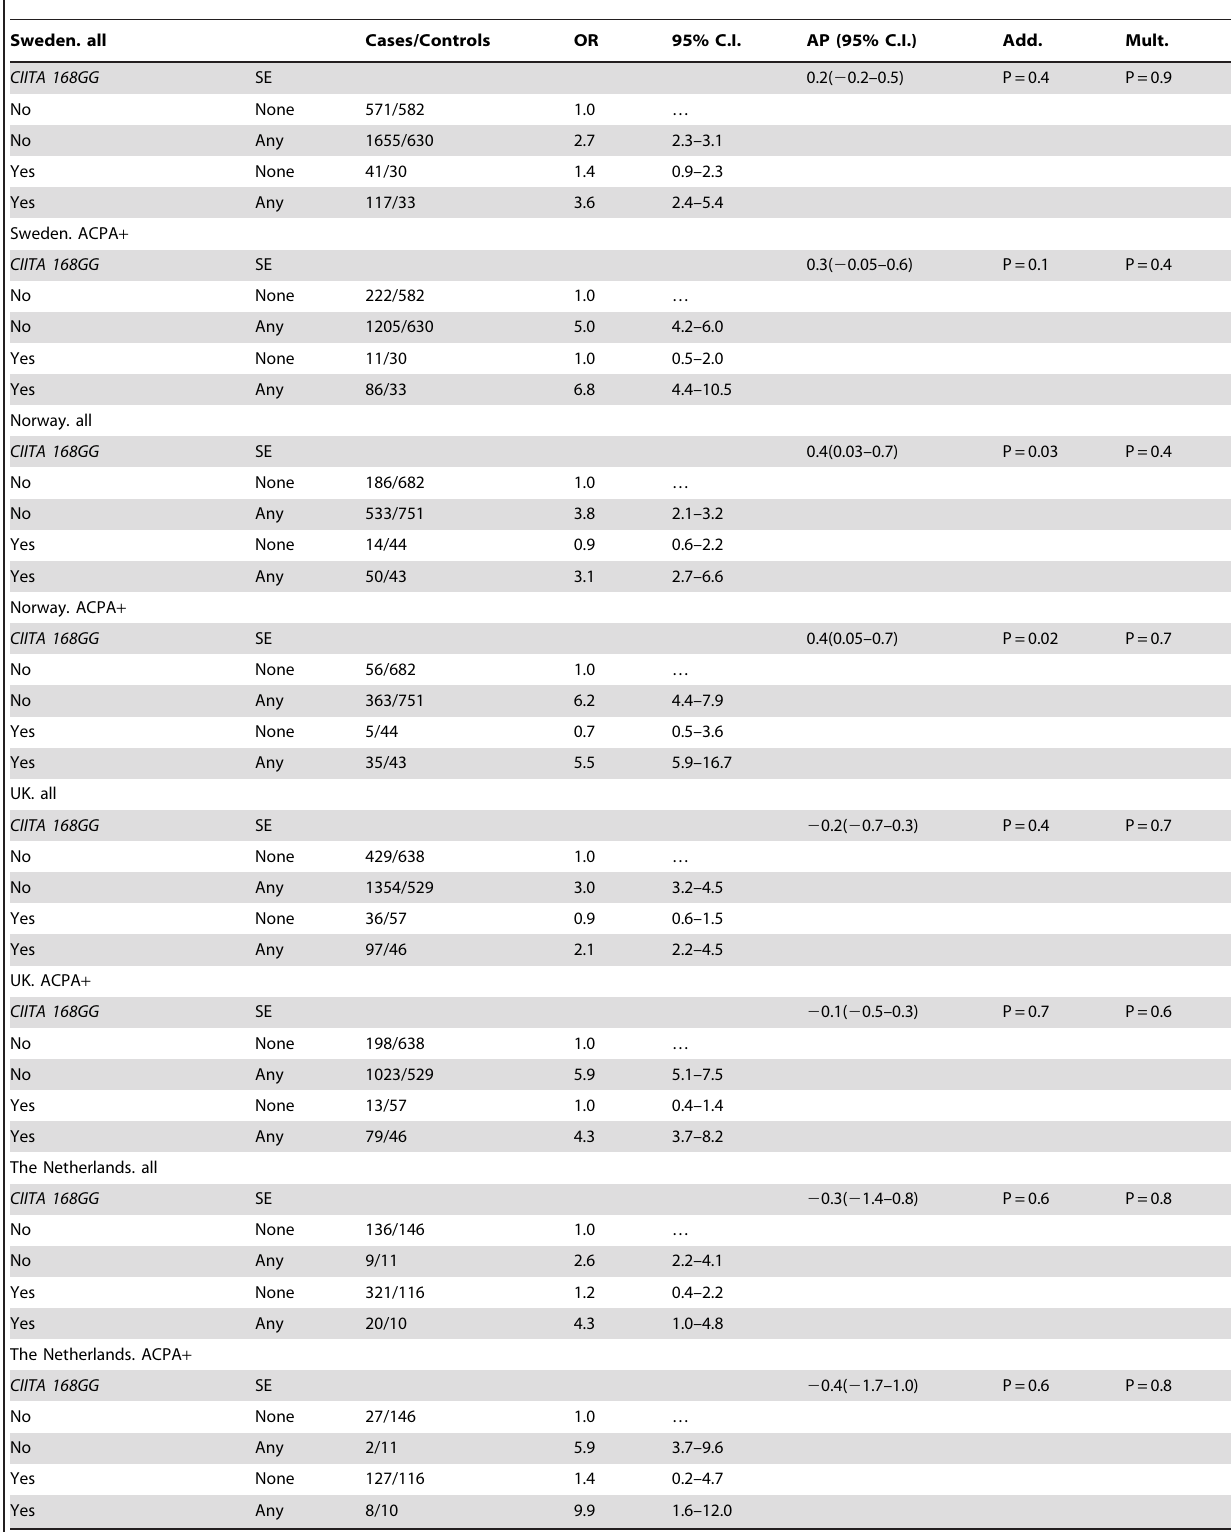
Table 1. Risk of developing RA for combinations of the HLA-DRB1 SE and rs3087456 alleles in Swedish.